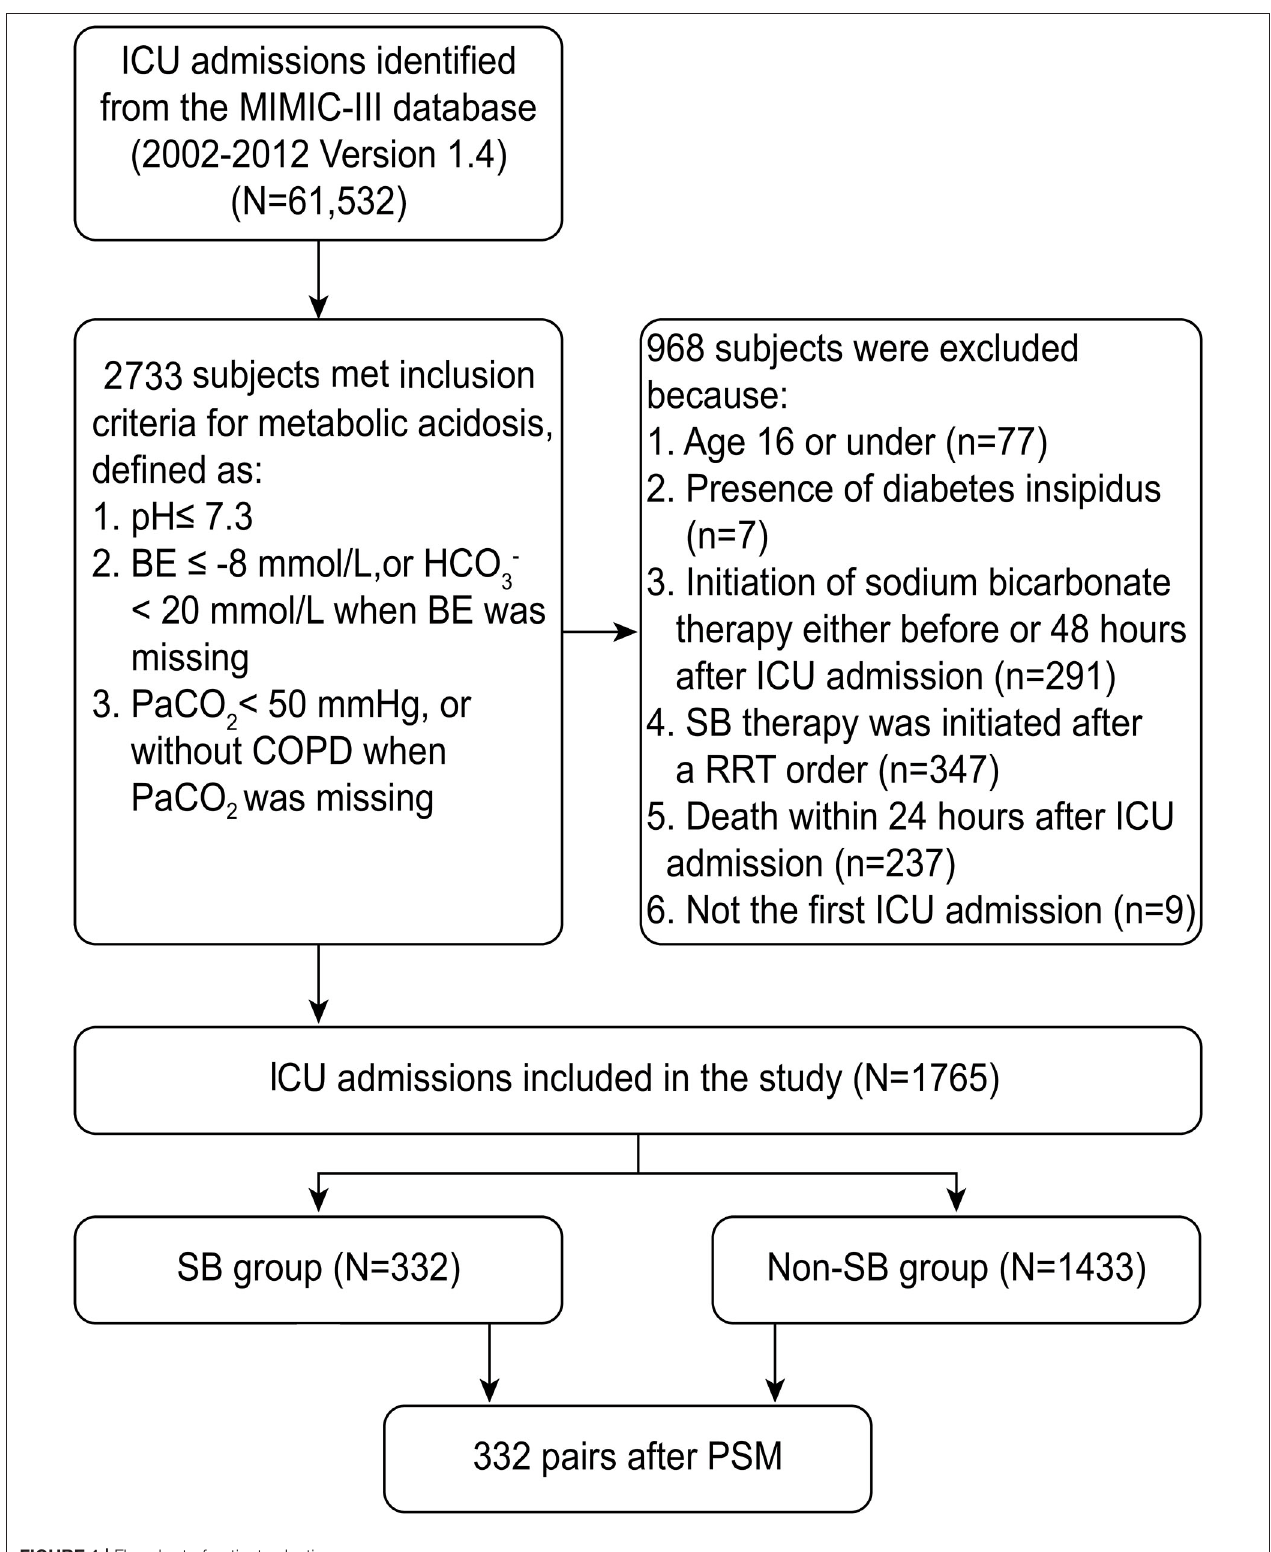
FIGURE 1 | Flowchart of patient